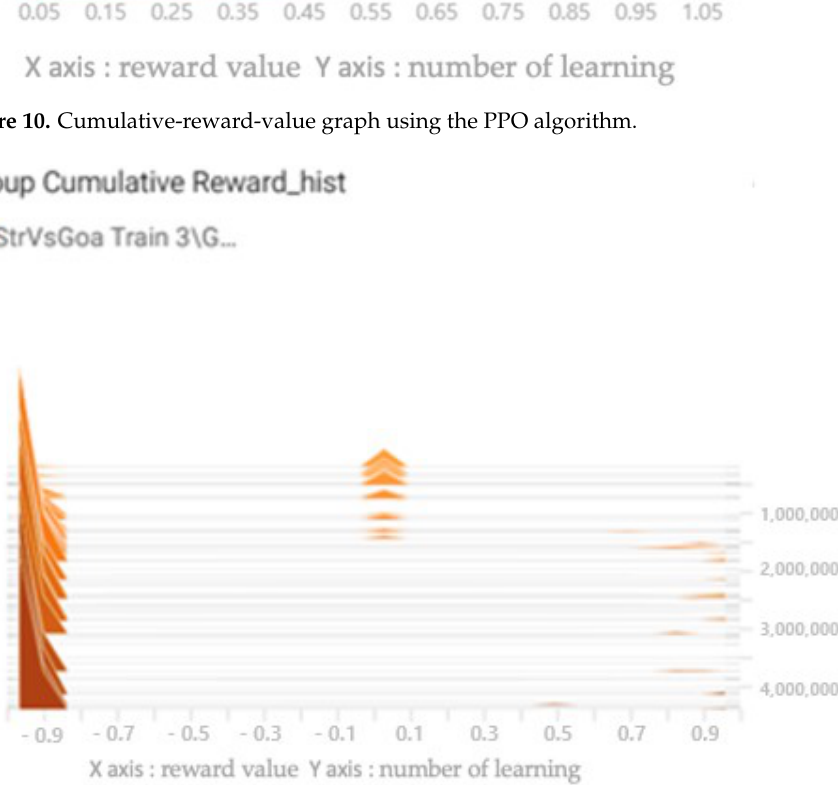
Figure 11 Cumulative-reward-value graph using the SAC algorithm.